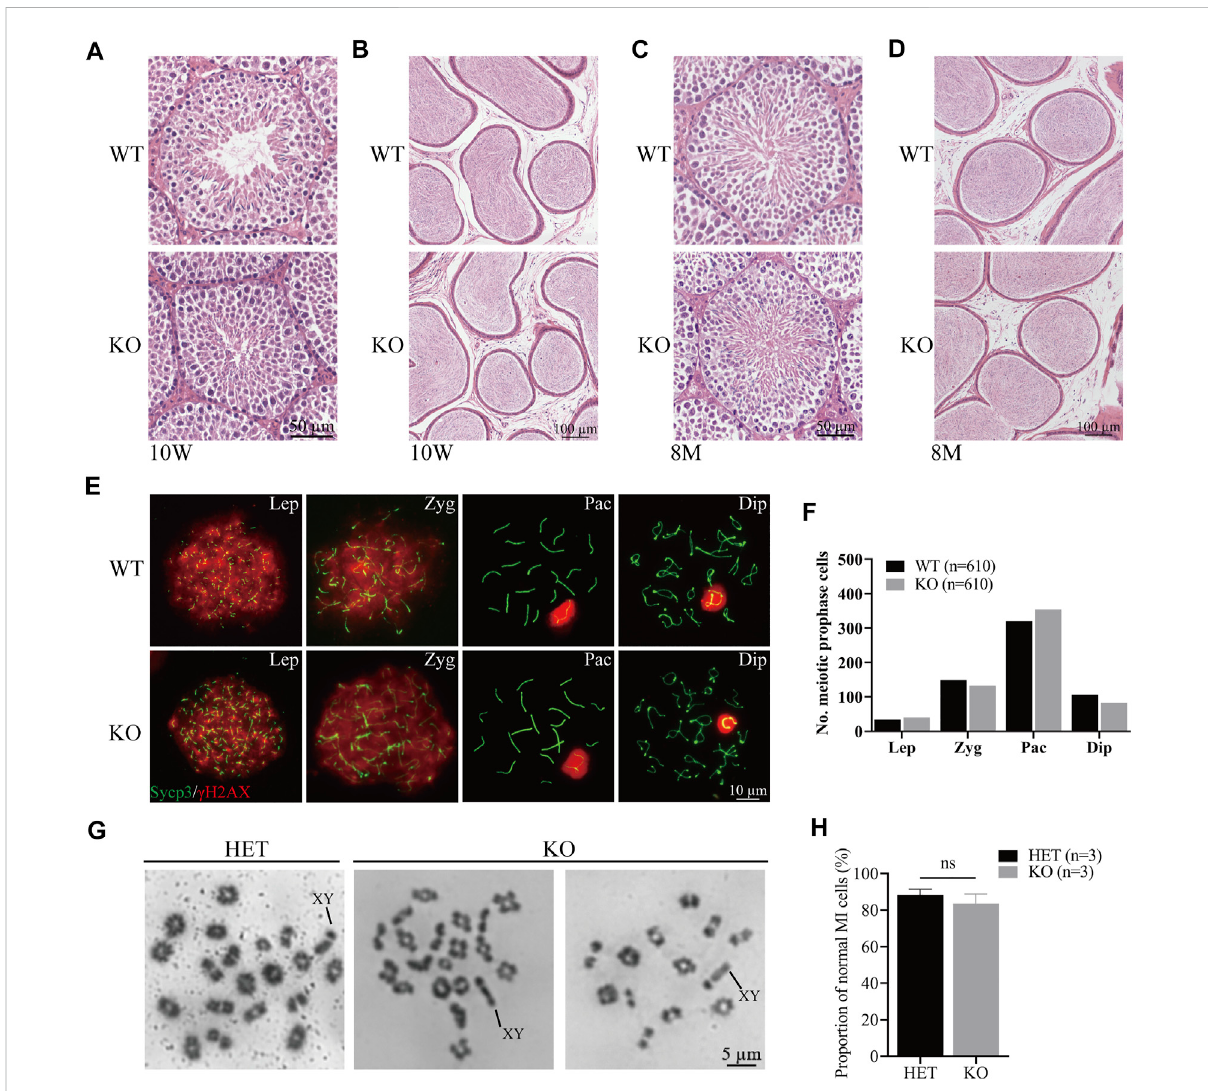
FIGURE 3 Meiosisprocessduring spermatogenesisisnormal in Cep72 KOmice. (A and B) H&Estainingofthetestisandepididymis from10-week-oldWT and Cep72 KO mice, respectively, bar = 50 and 100 μ m. (C and D) H&E staining of the testis and epididymis from 8-month-old WT and Cep72 KO mice,respectively, bar=50and100 μ m. (E) RepresentativespreadspermatocytesstainedforSycp3(green)and γ H2AX(red)fromWTand Cep72 KO mice,bar=10 μ m.Lep,leptotene;Zyg.zygotene;Pac,pachytene;Dip,diplotene. (F) NumberofmeioticprophasecellsatLep,Zyg,Pac,andDip stagesfromWTand Cep72 KOmice(threemicepergenotypeused,610WTand610 Cep72 KOcellsscored). (G) AnalysisofchiasmatainmetaphaseI (MI) spermatocytes from HET and Cep72 KO mice at 4 weeks. The black lines indicate the XY chromosome. Scale bar = 5 μ m. (H) Quanti fi cation of chiasmata MI cells. The data are from three mice per genotype; ns: no signi fi cant